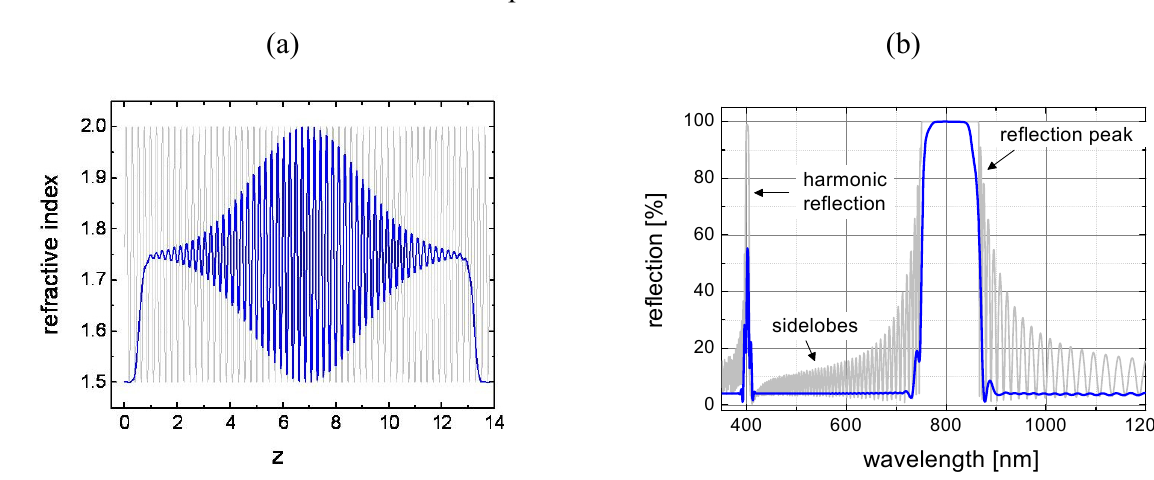
Figure 2. (a) Refractive index profile and (b) reflection characteristics of a normal Rugate filter (light grey) and an optimized Rugate filter (blue). The optimized refractive index profile is enveloped with a Gaussian function and matched to a material with n = 1.5. The related reflection characteristic shows that sidelobes are suppressed, but the first harmonic reflection has not vanished completely. Furthermore, the reflection peak of the optimized filter is narrower than that of the un-optimized